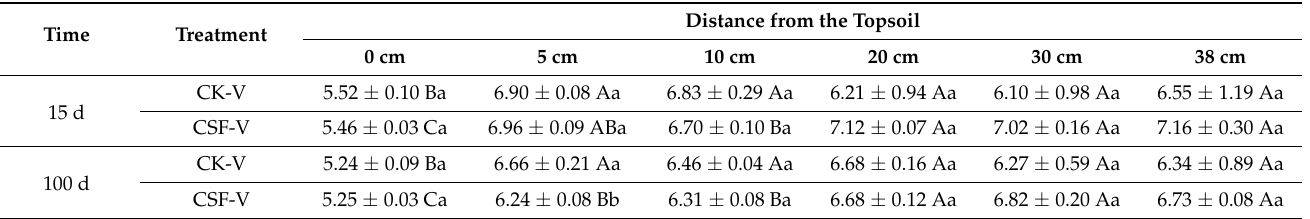
Table 3. The pH changes in the different vertical soil layers with CSF